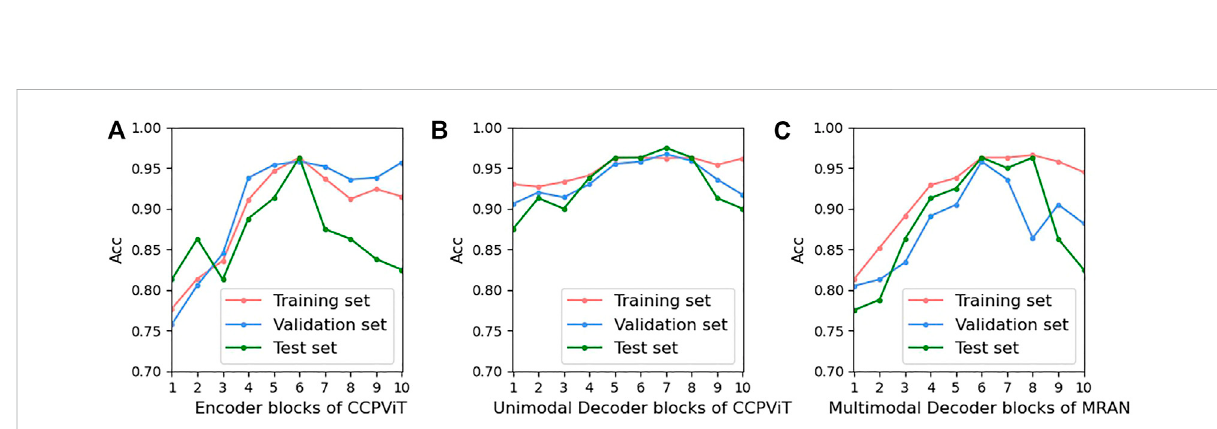
FIGURE 8 Effects of the encoder and decoder blocks on model prediction. The red, green, and blue curves refer to the training, validation, and test sets, respectively. Multimodal decoder blocks contain multi-head attention and CAB (select ViT-B/16 and set α (cid:1) 0 . 3; β (cid:1) 0 . 7). (A) Encoder blocks of CCPViT; (B) Unimodal Decoder blocks of CCPViT; (C) Multimodal Decoder blocks of